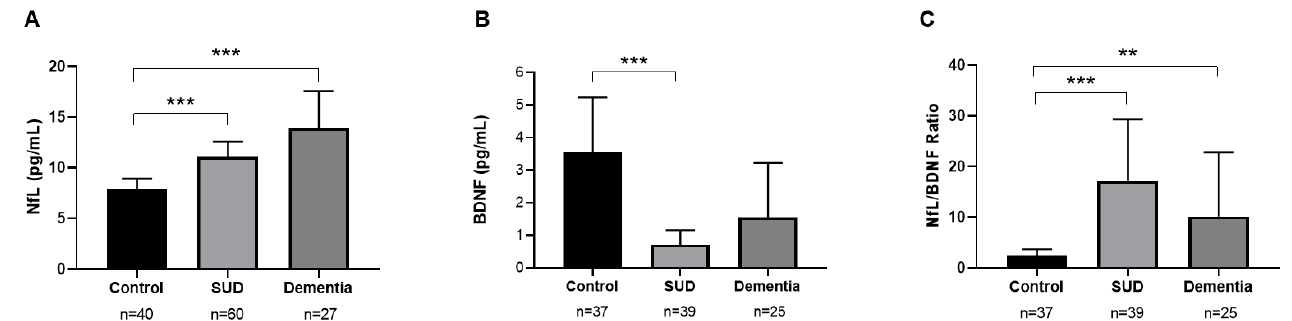
Figure 1. Plasma concentrations of neurofilament light chain (( A ), NfL), Brain-derived neurotrophic factor (( B ), BDNF) and ratio of NfL/BDNF ( C ) according to experimental groups. Data were ana- lyzed by one-way analysis of covariance (ANCOVA). Bars are estimated marginal means and 95% confidence intervals. *** p < 0.001 and ** p < 0.010 denote a significant main effect of the group factor.